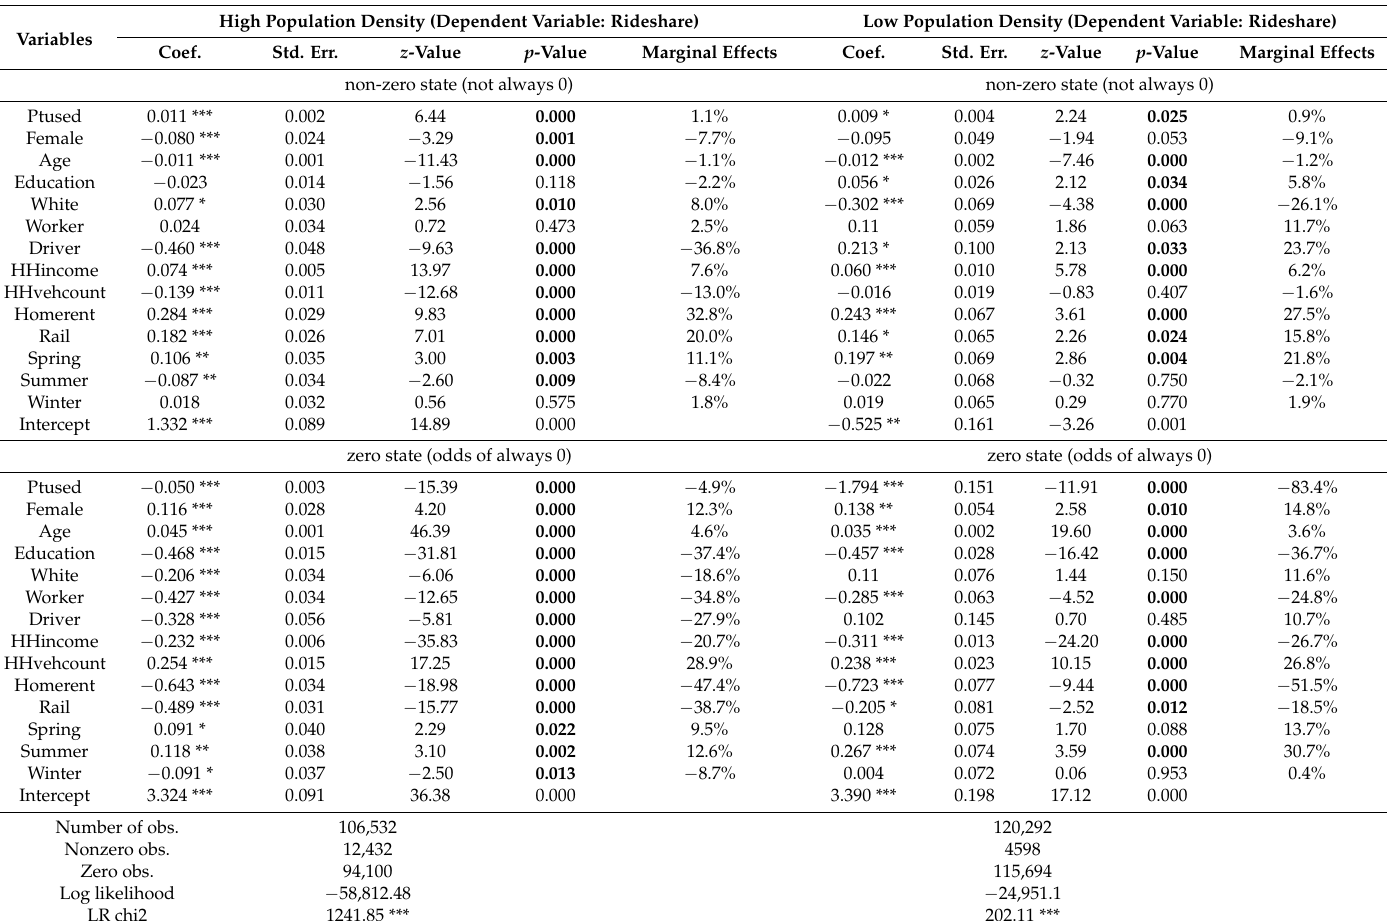
Table 3. Results for the relationship between ridesharing and public transit use varying by population density. High Population Density (Dependent Variable: Rideshare) Low Population Density (Dependent Variable: Rideshare) Variables Coef. Std. Err. p -Value Marginal Effects Coef. Std. Err. z -Value p -Value Marginal Effects non-zero state (not always 0)